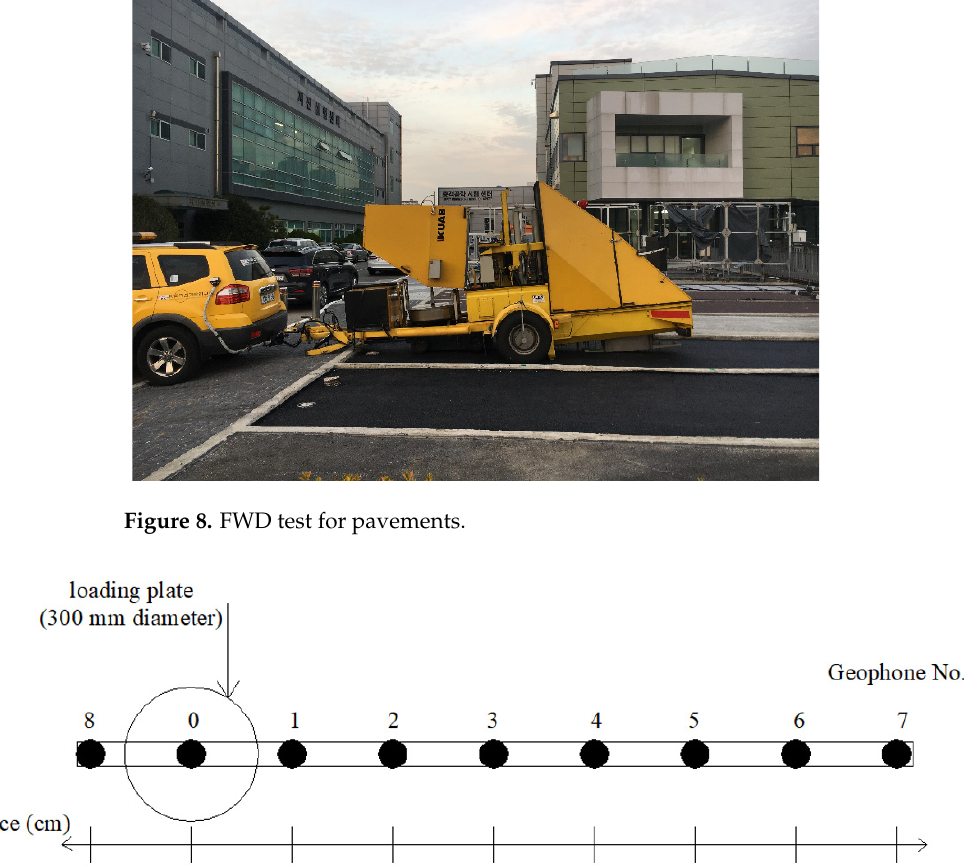
Figure 8. FWD test for pavements.